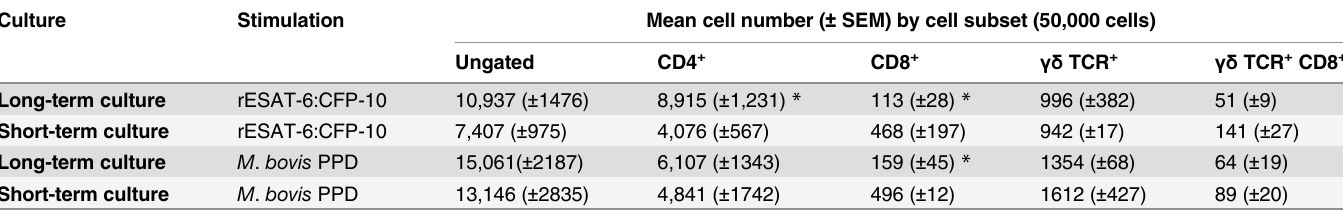
Table 2. Lymphocyte subset proliferative responses of M . bovis -infected cattle under short or long-term culture condition.